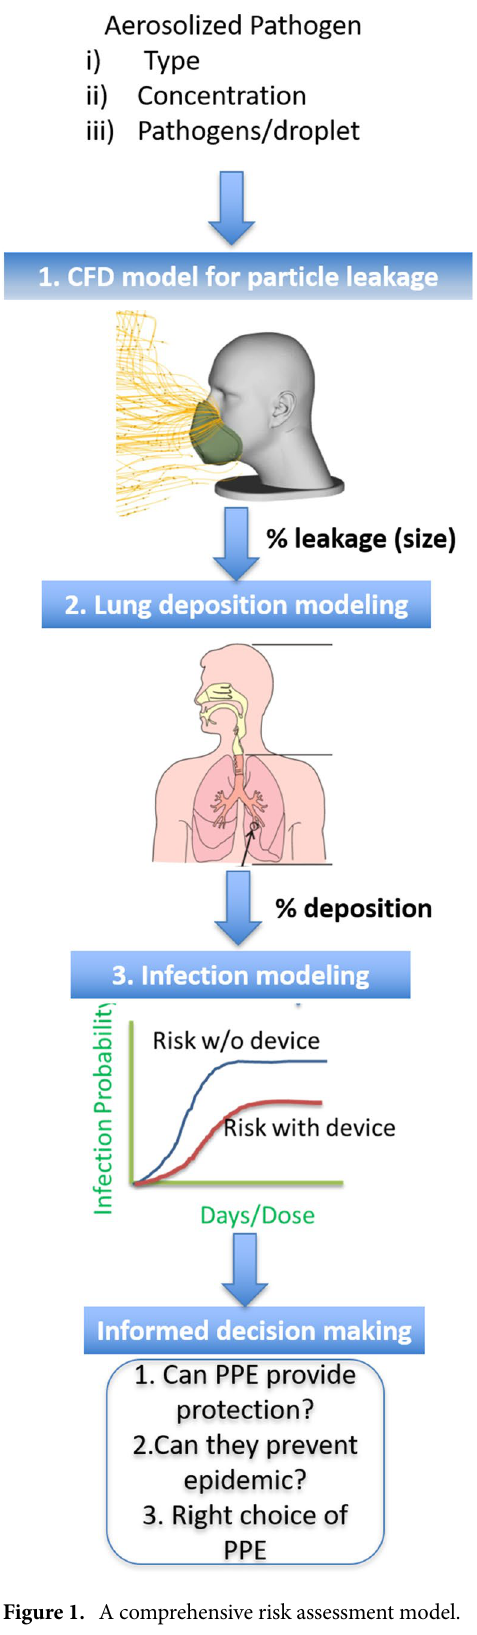
Figure 1. A comprehensive risk assessment